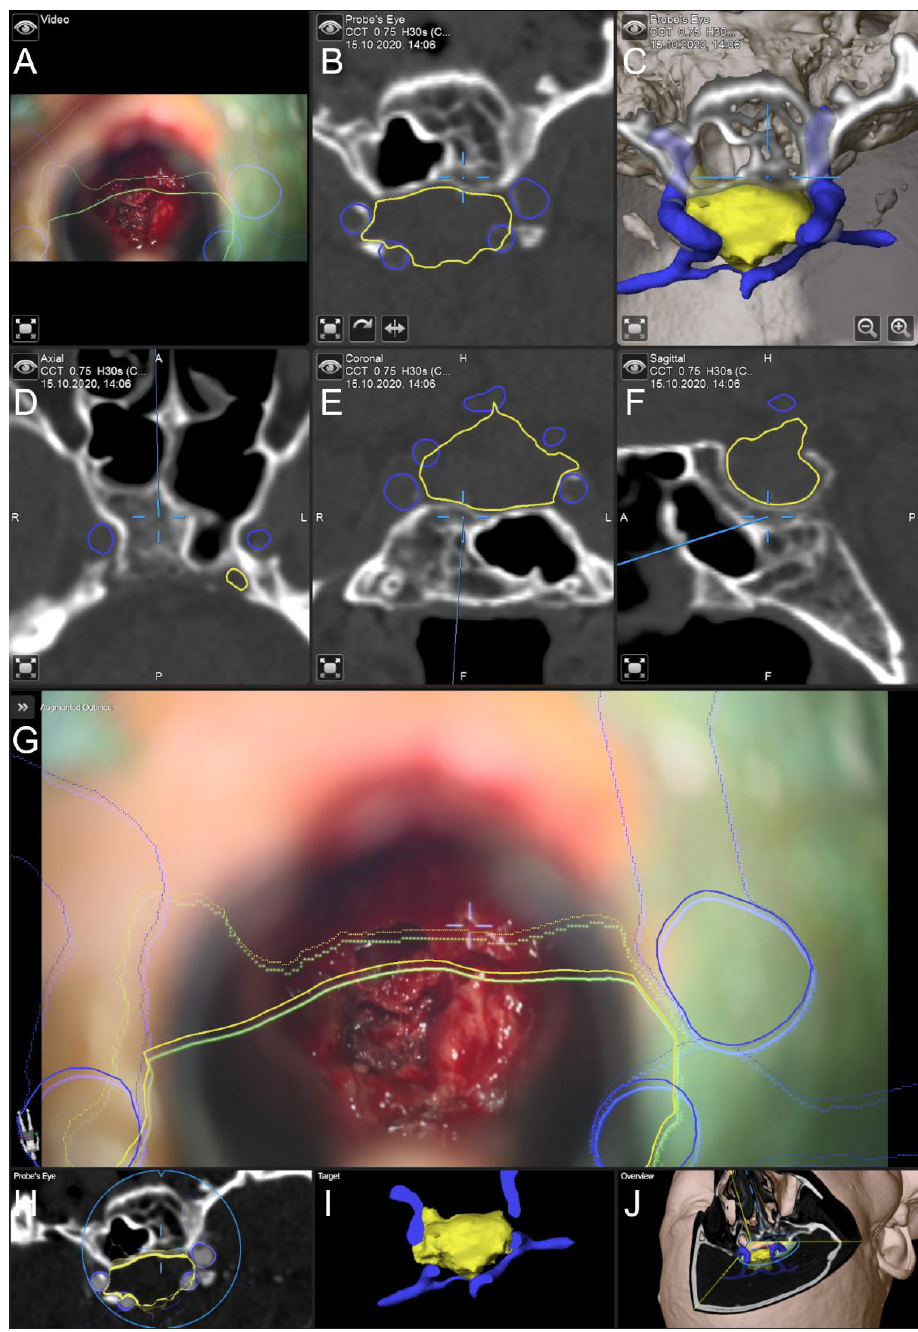
Figure 4. Navigation and AR support in the case of an 84-year-old male patient with previous surgery of a gonadotropic pituitary adenoma. Pre-segmented objects include the lesion (yellow), and the carotid arteries (blue). ( A ) Microscope video with 3D visualization of segmented objects using the head-up display. ( B ) The 2D and ( C ) 3D probe’s eye view of preoperative CT data with 3D visualization of segmented objects. ( D ) Axial, ( E ) coronal, and ( F ) sagittal view (standard navigation) of preoperative CT data with focus on a calcified second layer beyond the sella turcica. ( G ) AR vis- ualization superimposed on the microscope video with a 3D representation of segmented structures. ( H ) Corresponding probe’s eye view, ( I ) target view (visualizing the lesion (selected as target) in an uncut manner while only parts of the remaining objects distal to the focus plane are displayed), and ( J ) 2D overview depicting the video plane in relation to the 3D visualization of all objects.